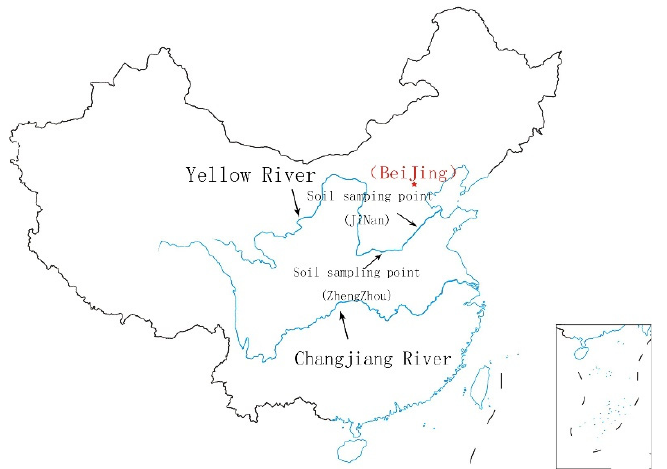
Figure 1. The location of the test soil.